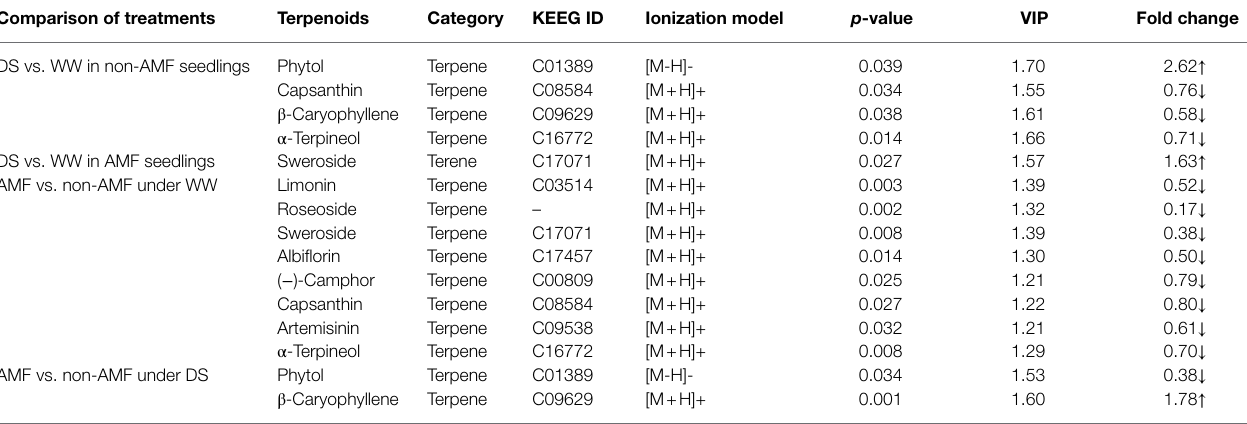
TABLE 1 | Changes in relative concentration and fold changes of terpenoids in differential metabolites in roots of trifoliate orange under well-watered (WW) and drought stress (DS) after AMF inoculation. Comparison of treatments